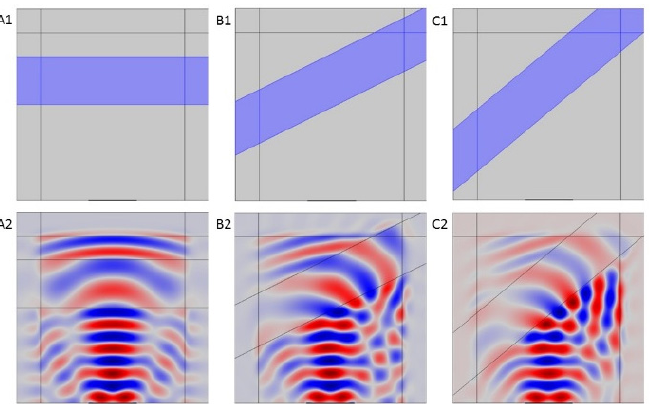
Figure A4. ( A1 ) Simulation configuration with material 2 in blue parallel (0°) to the transducer surface. ( A2 ) Propagation of an ultrasonic wave through the two materials for a normal incidence (0°). ( B1 ) Simulation configuration with material 2 in blue with a 26.5° angle with the transducer surface ( B2 ) Propagation of an ultrasonic wave through the two materials for at the intromission angle (26.5°) with the transducer surface. ( C1 ) Simulation configuration with material 2 in blue with a 40° angle with the transducer surface ( C2 ) Propagation of an ultrasonic wave through the two materials for an angle above the critical angle (40°) with the transducer.